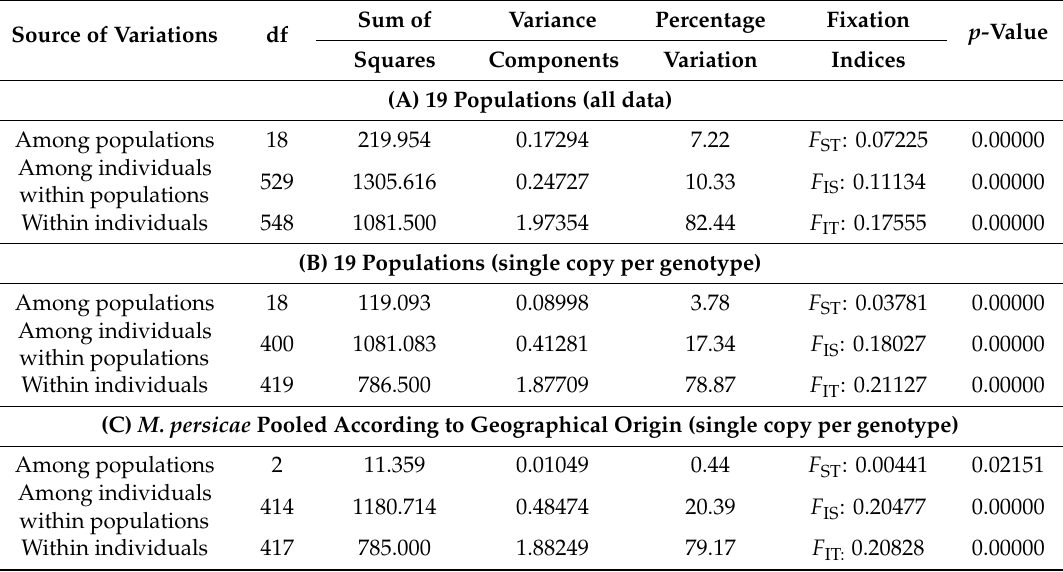
Figure 3. Neighbor-joining tree showing the genetic relatedness among the 397 MLGs found on M. persicae populations from Tunisia. Sampled individuals were genotyped at six microsatellite loci and the tree was built based on allele shared distance (DAS method). The total number of genotypes within each group is shown, but only multicopy MLGs are cited with their frequencies in parentheses. The genetic distance among MLGs was computed considering a bootstrap of 1000 replicates. Table 8. Hierarchical analyses of the molecular variance AMOVA for M. persicae aphids from Tunisia. df: Degrees of